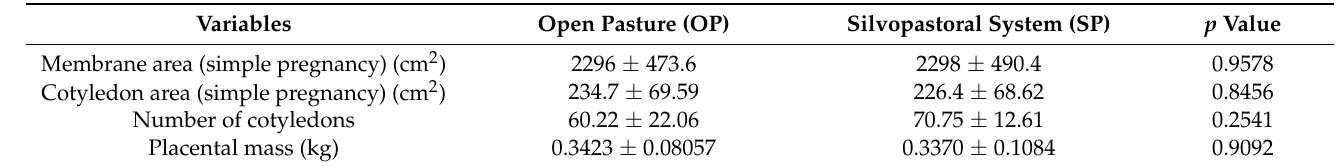
Table 4. Mean values (mean ± SEM) of the placental biometry of ewes kept in the silvopastoral system (SP) and open pasture